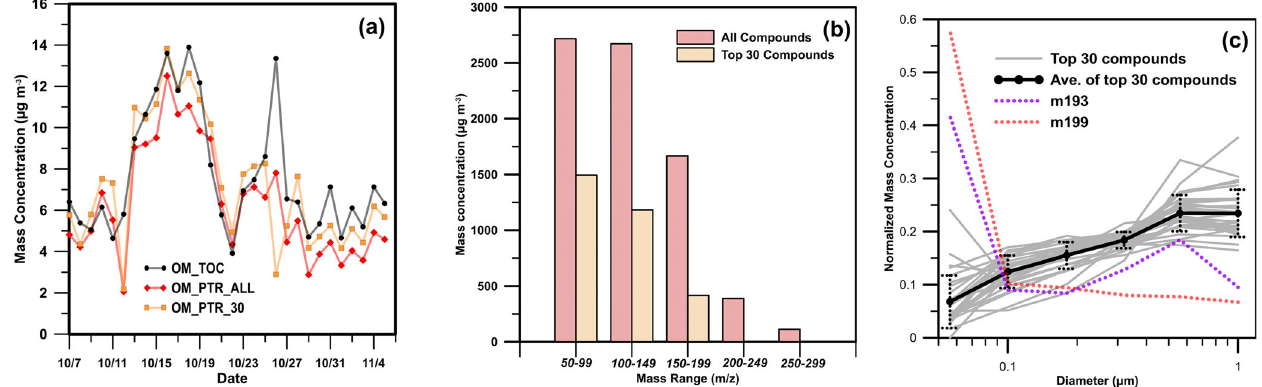
Fig. 1 Characteristics of the organic ions in the experimental forest. a Time series pro fi le of the daytime mass concentration of submicron OM, the sum of all ions from the thermal desorption analysis (TD-PTR-ToF-MS, all), and the sum of mass concentration of the 30 major ions indicated in Table 1. b Breakdown of the contribution of different mass ranges to the overall mass concentration of all the ions from MS and top 30 ions. c Size distribution pro fi le (<1.0 μ m) of the normalized concentration to the sum of mass concentration of major organic ions. The strong bold line indicates the average of all the tracers. Included in the graph are the size distribution pro fi les of the ions at 193 and 199 (dotted lines). The error bars represent the range of ±1 standard